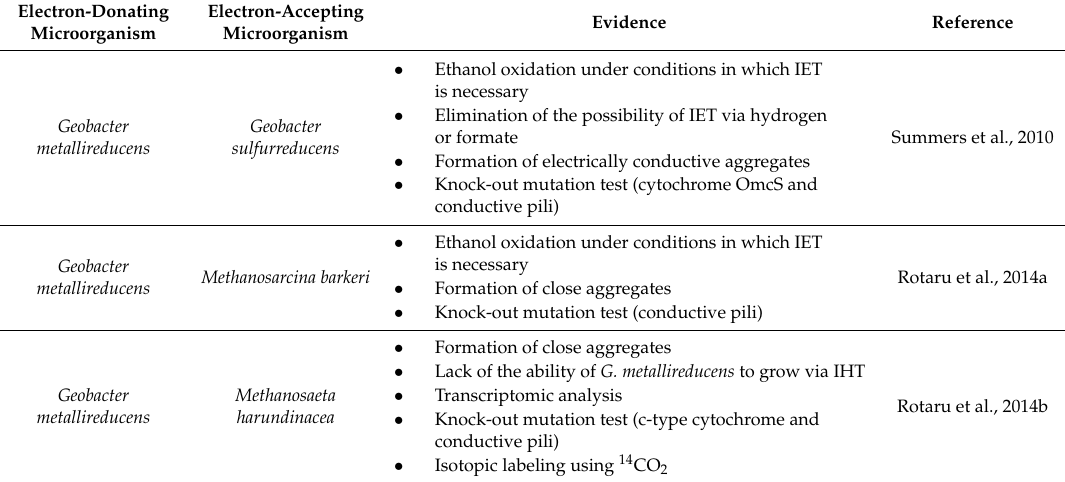
Table 2. Observational and experimental evidence for biological direct interspecies electron transfer (DIET) in defined